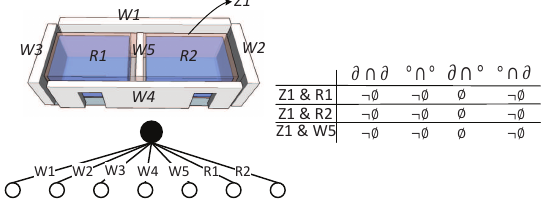
Figure 2. Covering relation represented by the original maptree